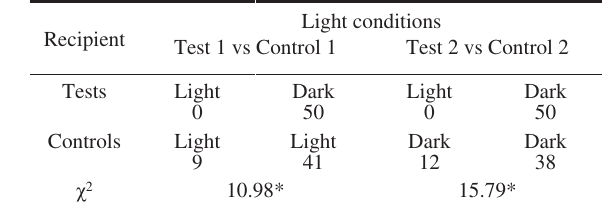
Table 1. – Phototaxis responses of Polygordius eschaturus (as num- ber of individuals on each half of four experimental recipients). χ 2 results comparing test vs controls. * p<0.05.